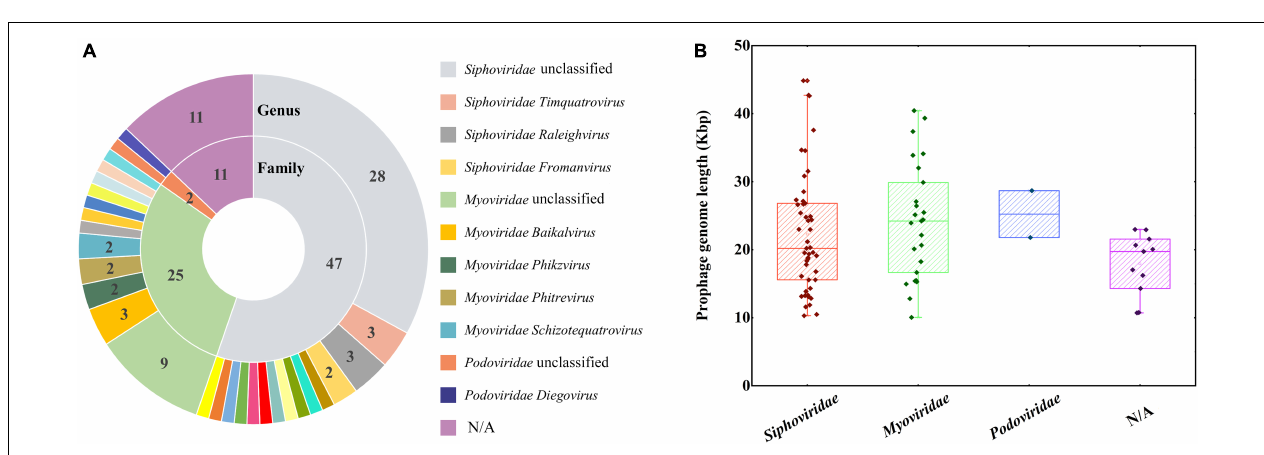
FIGURE 5 | The copy number of insertion sequences (A) , the families of ISs (B) , and the putative laterally transferred regions contain ISs (C) .